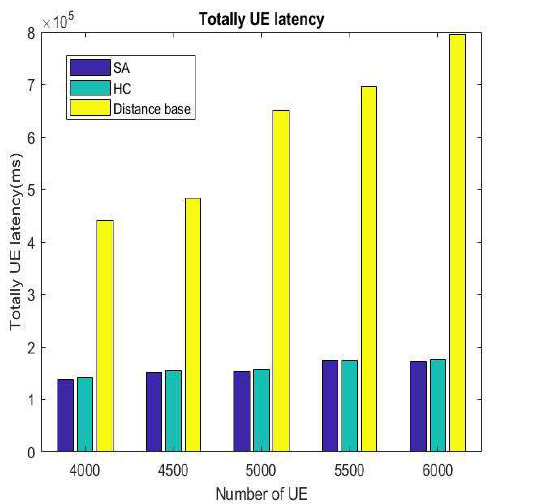
Figure 15. Total latency for number of different VUEs.